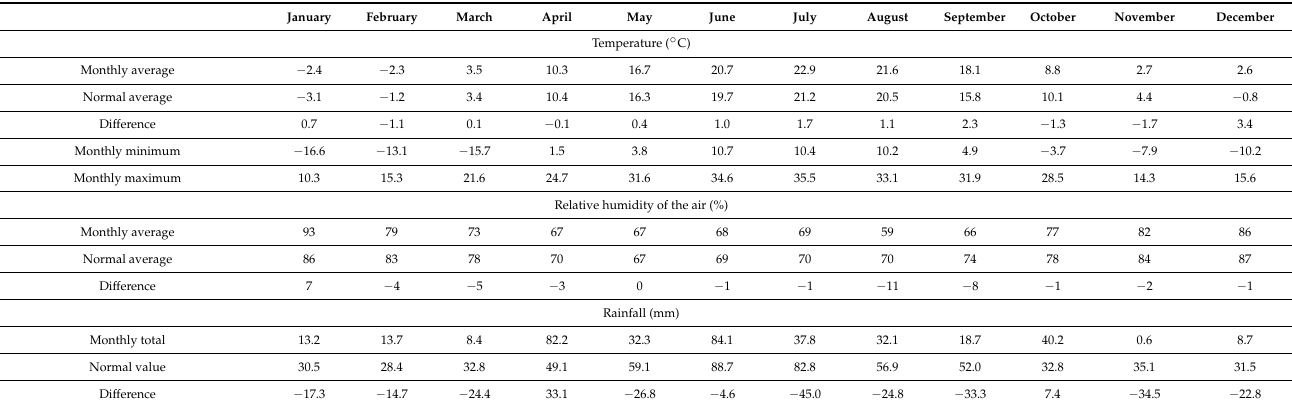
Table 1. Climate data for the first year, 2020.